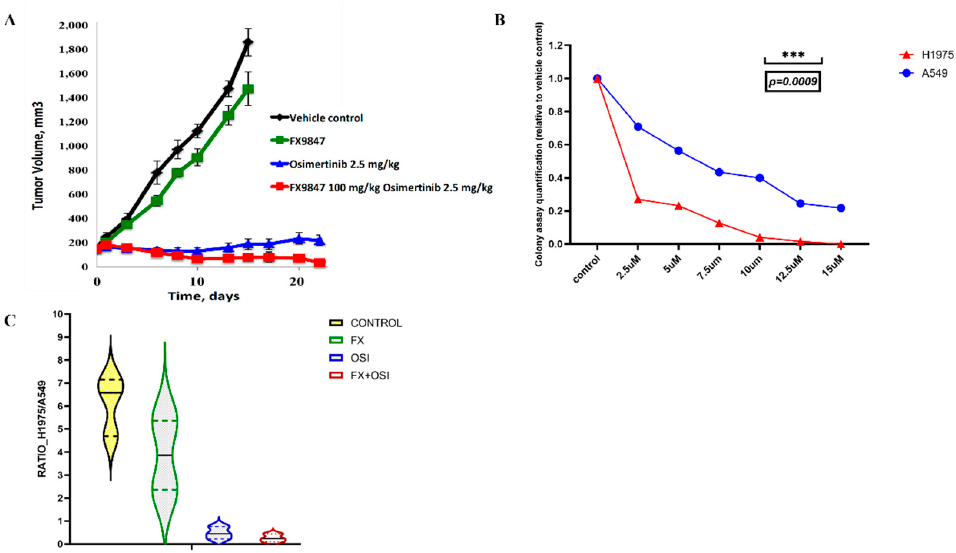
Figure 2. Effects of drugs combination treatments on primary tumors. ( A ) Effects of osimertinib and FX9847 and their combination on xenograft tumor growth measured by the caliper. Xenografts were established with H1975 lung cancer cells, and mice (10 animals per group) were treated with either osimertinib or FX9847 or their combination as described in the Materials and Methods section. ( B ) Sensitivity of H1975 and A549 cells to osimertinib (7 days of treatment). Cell viability was measured by the colony growth assay. ( C ) Effects of osimertinib and FX9847 and their combination on the primary tumors. The number of reads corresponding to H1975 cells was normalized by the number of reads that represent A549 cells. ***, p <